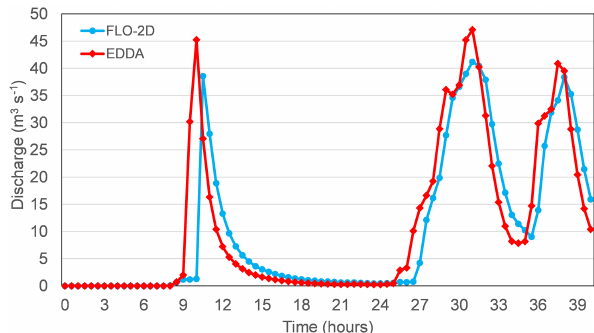
Figure 7. Comparison of the outflow hydrographs at the ravine mouth using FLO-2D and EDDA